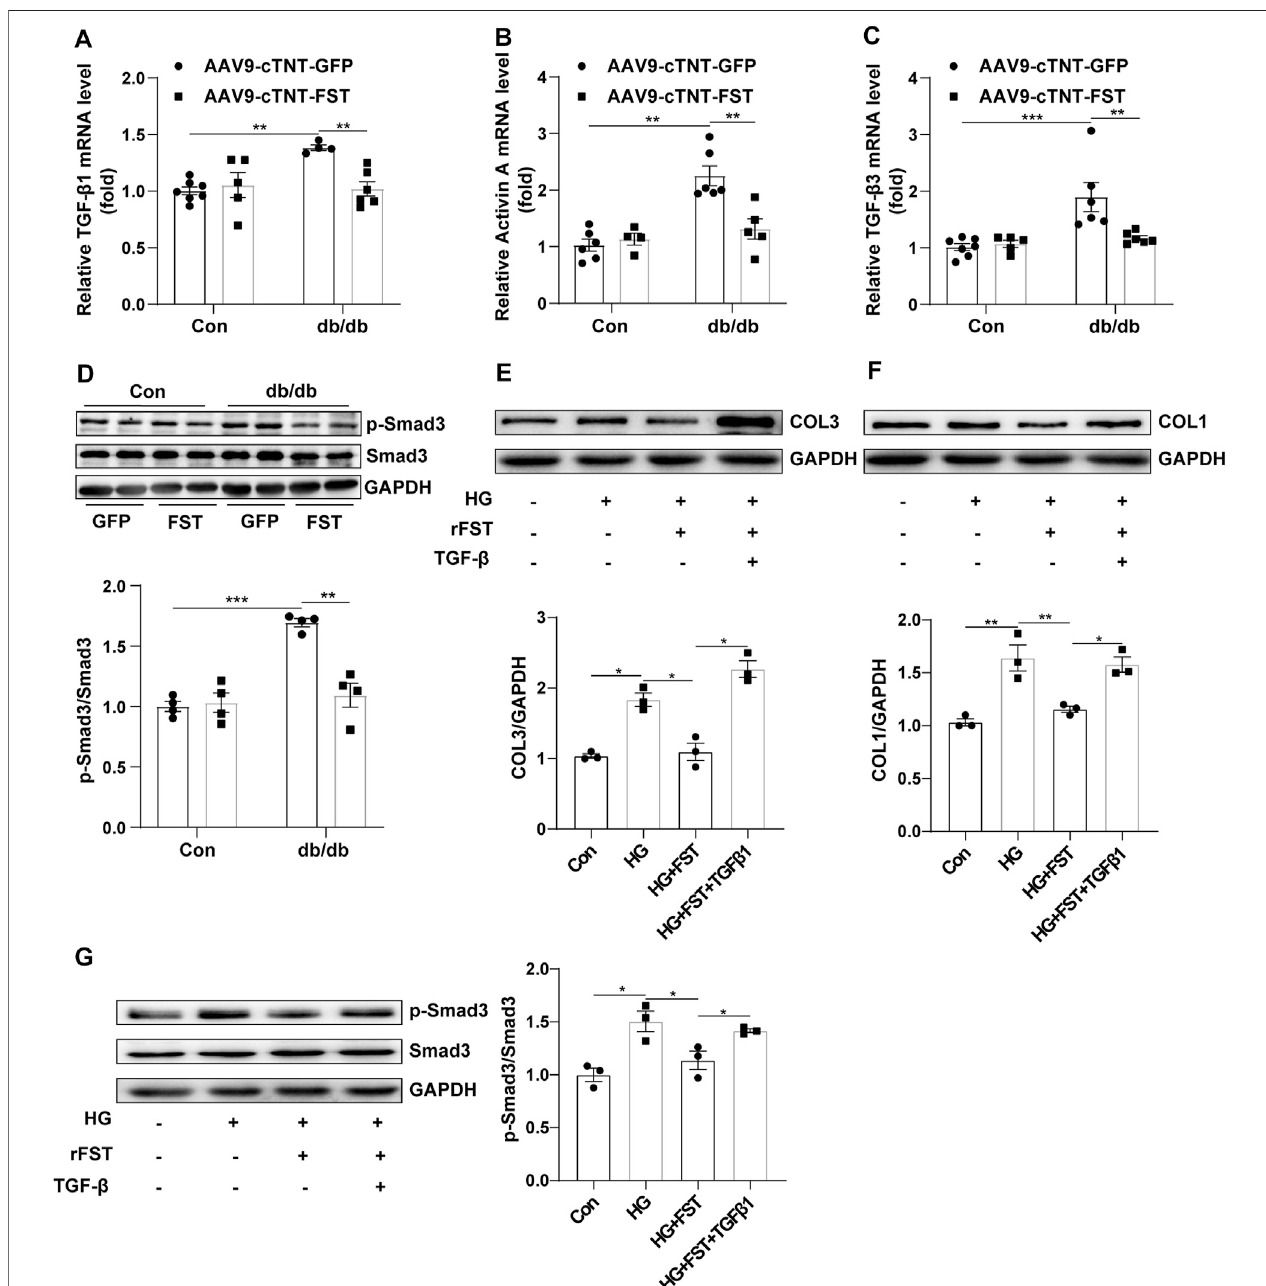
FIGURE5| OverexpressionofFSTreducescardiac fi brosisbyinhibitingtheactivationoftheTGF- β – Smad3pathway invivo and invitro .Quantitativereal-timePCR analysisofTGF- β 1,activinA,andTGF- β 3mRNAtranscription[ (A – C) , n ≥ 4]and p -Smad3andSmad3protein expressionineachgroup[ (D) , n (cid:1) 4]. Invitro ,NIH3T3cells weretreatedwithorwithouthighglucose(30 mM),recombinantFSTprotein(10 ng/ml),andTGF- β 1(20 μ M).ProteinexpressionofCOL1,COL3, p -Smad3,andSmad3 with different treatments [ (E – G) , n (cid:1) 3]. * p < 0.05; ** p < 0.01; *** p < 0.001.